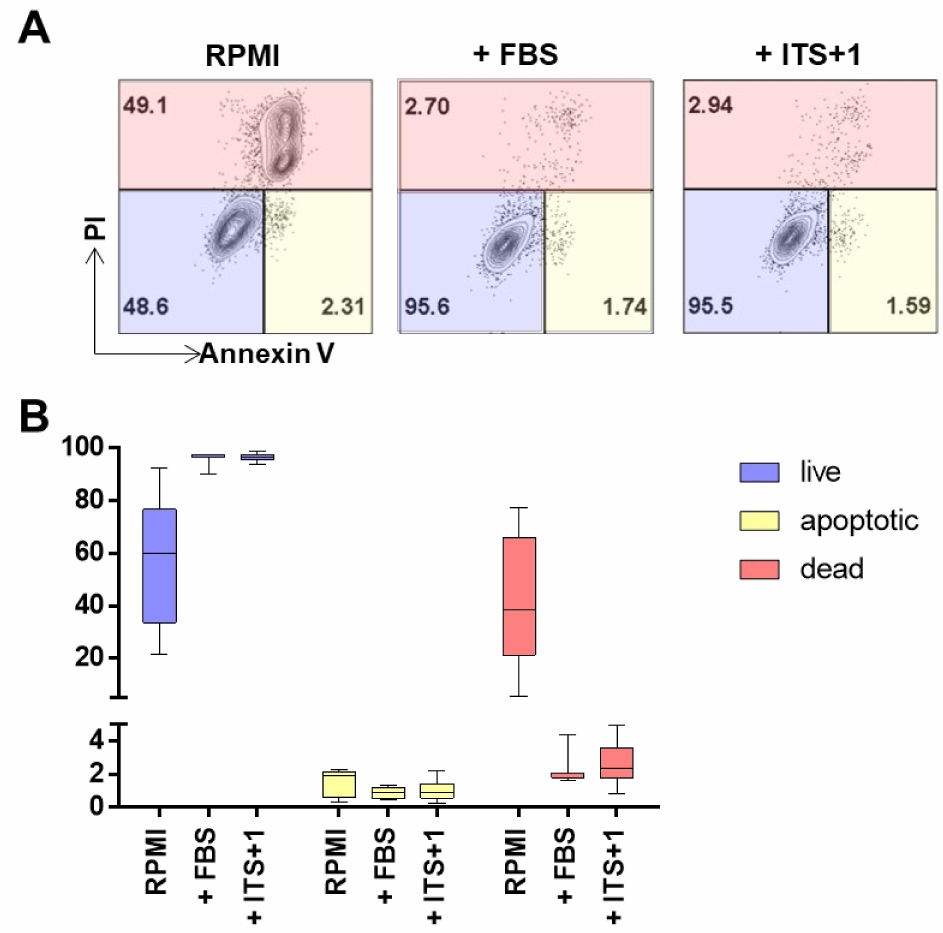
Figure A2. Monitoring cell death in defined culture conditions for AML cells. Defined media conditions were used to culture AML cell lines for at least five passages before harvesting and assessing apoptosis by flow cytometry. Culture conditions varied accordingly: RPMI defines RPMI complemented with Dipeptiven, HEPES and antibiotics; FBS defines basic medium supplemented with 10% heat inactivated FBS and ITS+1 defines basic medium supplemented with 1X ITS+1. ( A ) Dot plots depict the percentage of gated events for live, dead and apoptotic cells for the different culture conditions. A representative example of cell line KG-1 is shown. Events gated as live show negative staining for propidium iodide (PI, y -axis) and annexin V-eF450 ( x -axis); dead events refer to the percentage of the population that is single positive for PI and apoptotic refers to the percentage of the population of annexin V single positive events. ( B ) Quantification of the flow cytometry analysis depicts live populations as blue bars, dead events in red and the percentage of apoptotic cells in yellow bars. (Details are described in the Section 2; n = 4 per culture condition, 3 technical replicates; 10,000